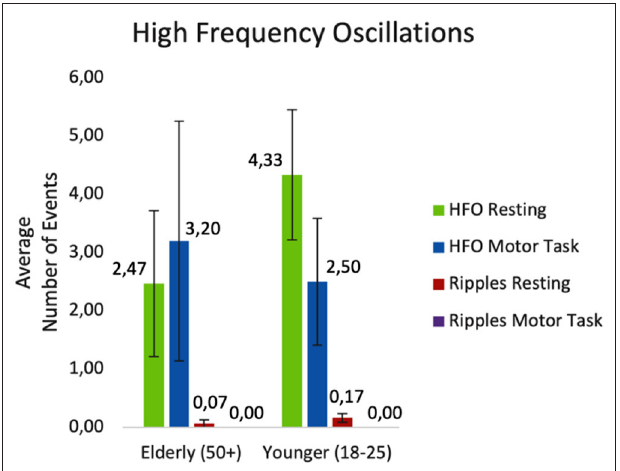
FIGURE 5 | Average number of events detected while resting and during the motor task. HFO, ripples and unclear HFOs combined; Ripples, HFOs at